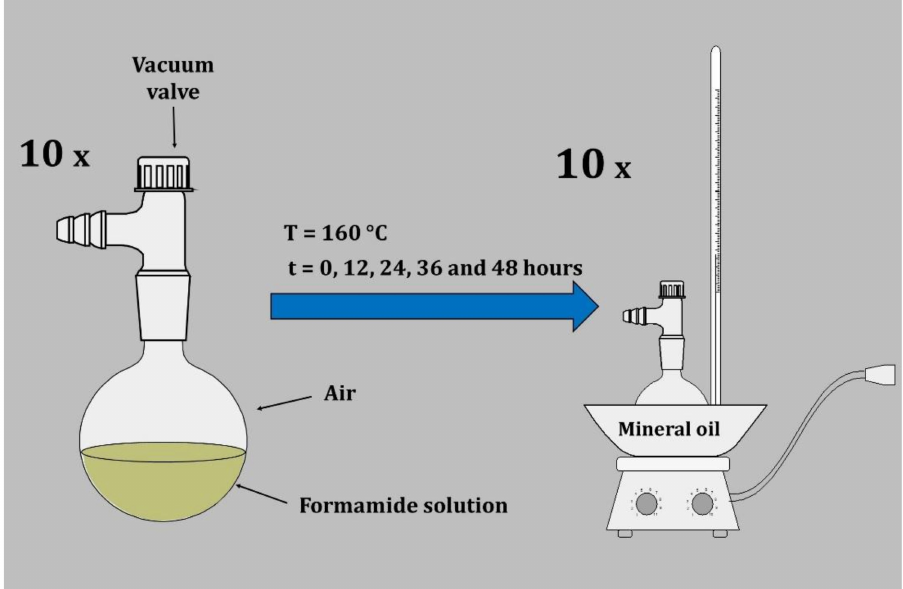
Figure 5. Sketch showing the experimental setup used for thermolysis.